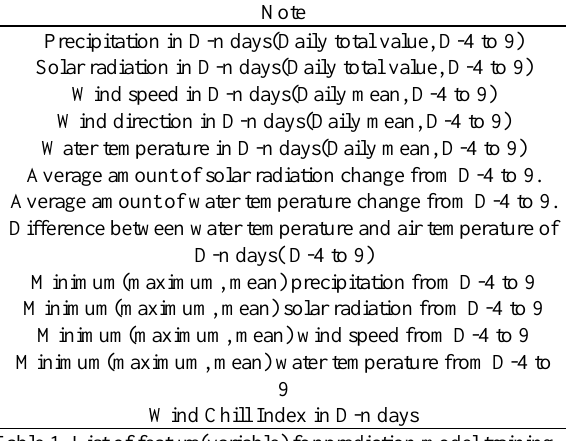
Table 1. List of feature(variable) for prediction model training